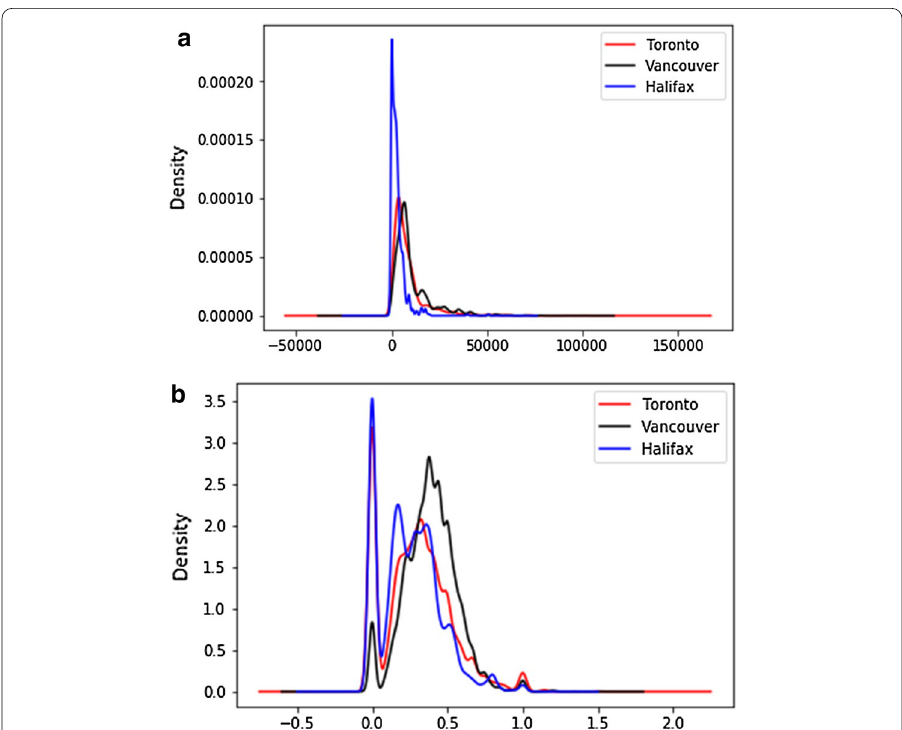
Fig. 5 Distribution differences among three domains. a Population density. b Mobility migrants